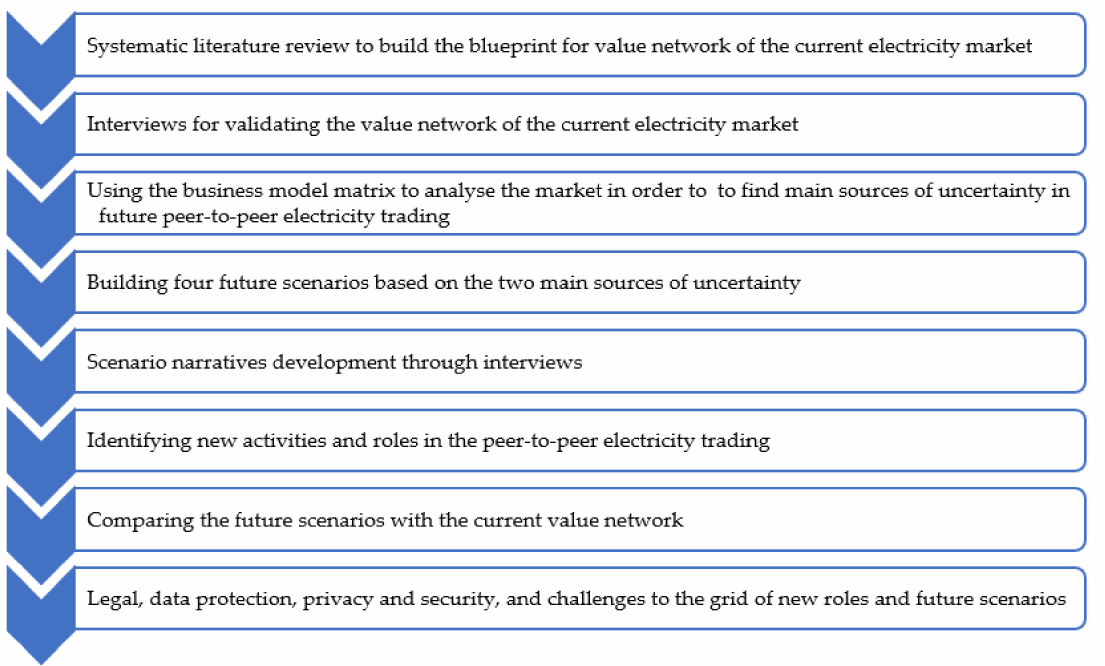
Figure 1. Research methods in sequential